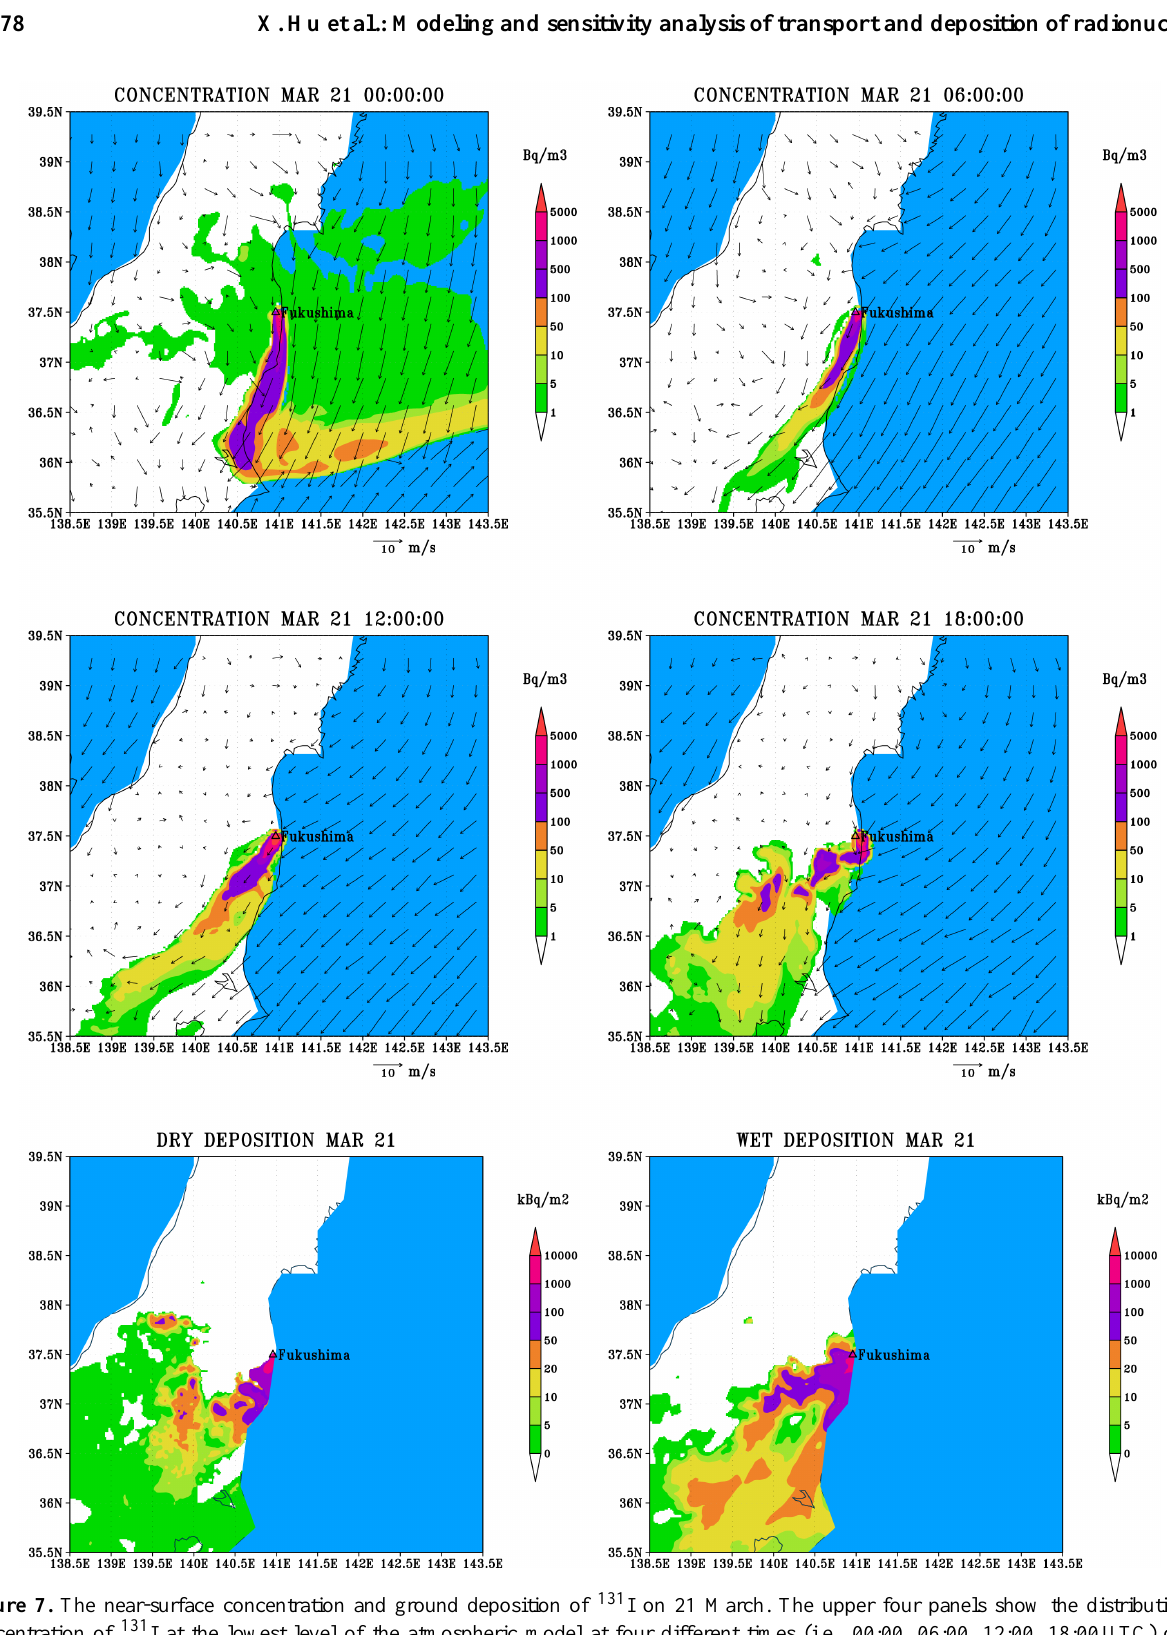
Figure 7. The near-surface concentration and ground deposition of 131 I on 21 March. The upper four panels show the distribution of concentration of 131 I at the lowest level of the atmospheric model at four different times (i.e., 00:00, 06:00, 12:00, 18:00UTC) on 21 March, in which the near-surface concentration is represented by instantaneous values. The bottom panels show the dry and wet deposition accumulated during 21 March. The results are from the simulation